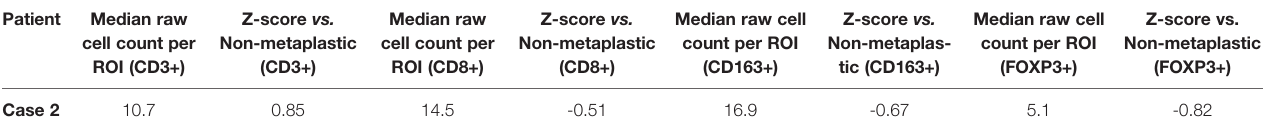
TABLE 1 | Immune cell counts in Case 2 by